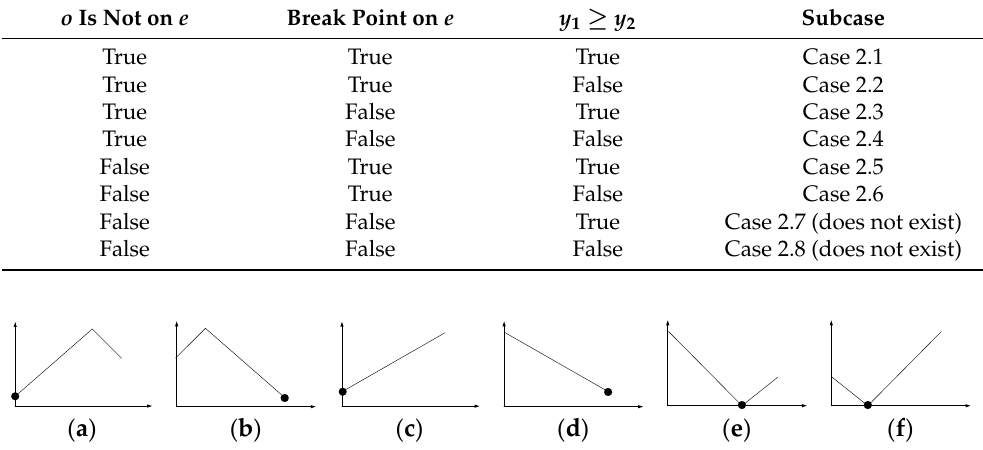
Figure A3. dist ( o , p ) × CI ( Q , p ) graphs for Case 2: ( a ) case 2.1, ( b ) case 2.2, ( c ) case 2.3, ( d ) case 2.4, ( e ) case 2.5, and ( f ) case 2.6.